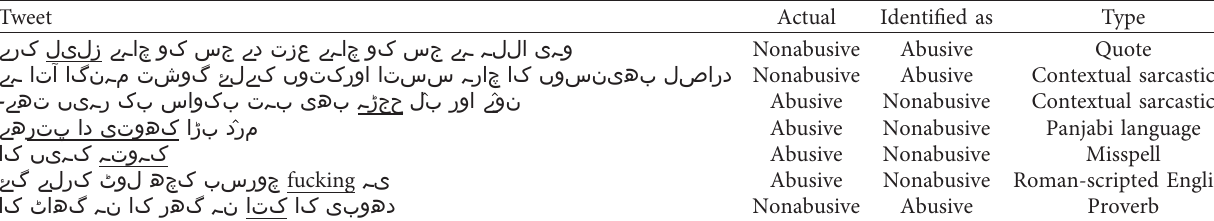
Table 4: Confusing Tweets with their